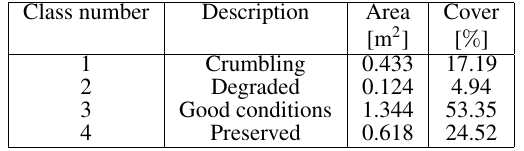
Figure 9: the maximum difference in the direction orthogonal to the DSM wall plane was evaluated as about 10 cm; indeed